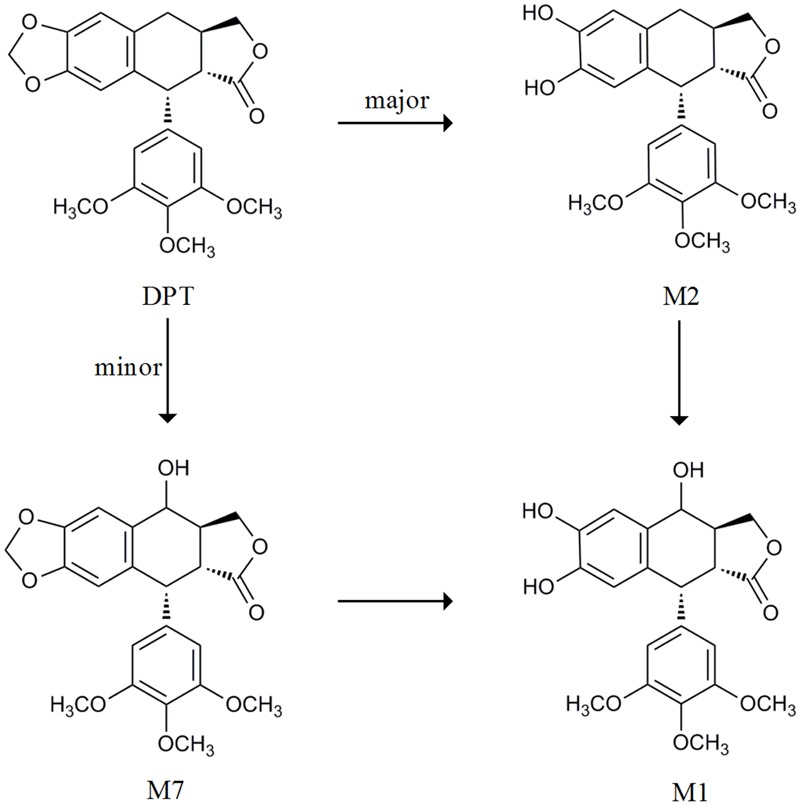
The metabolic pathway from DPT to its main metabolites cited from Lee et al. (2008) and Xie et al. (2016).